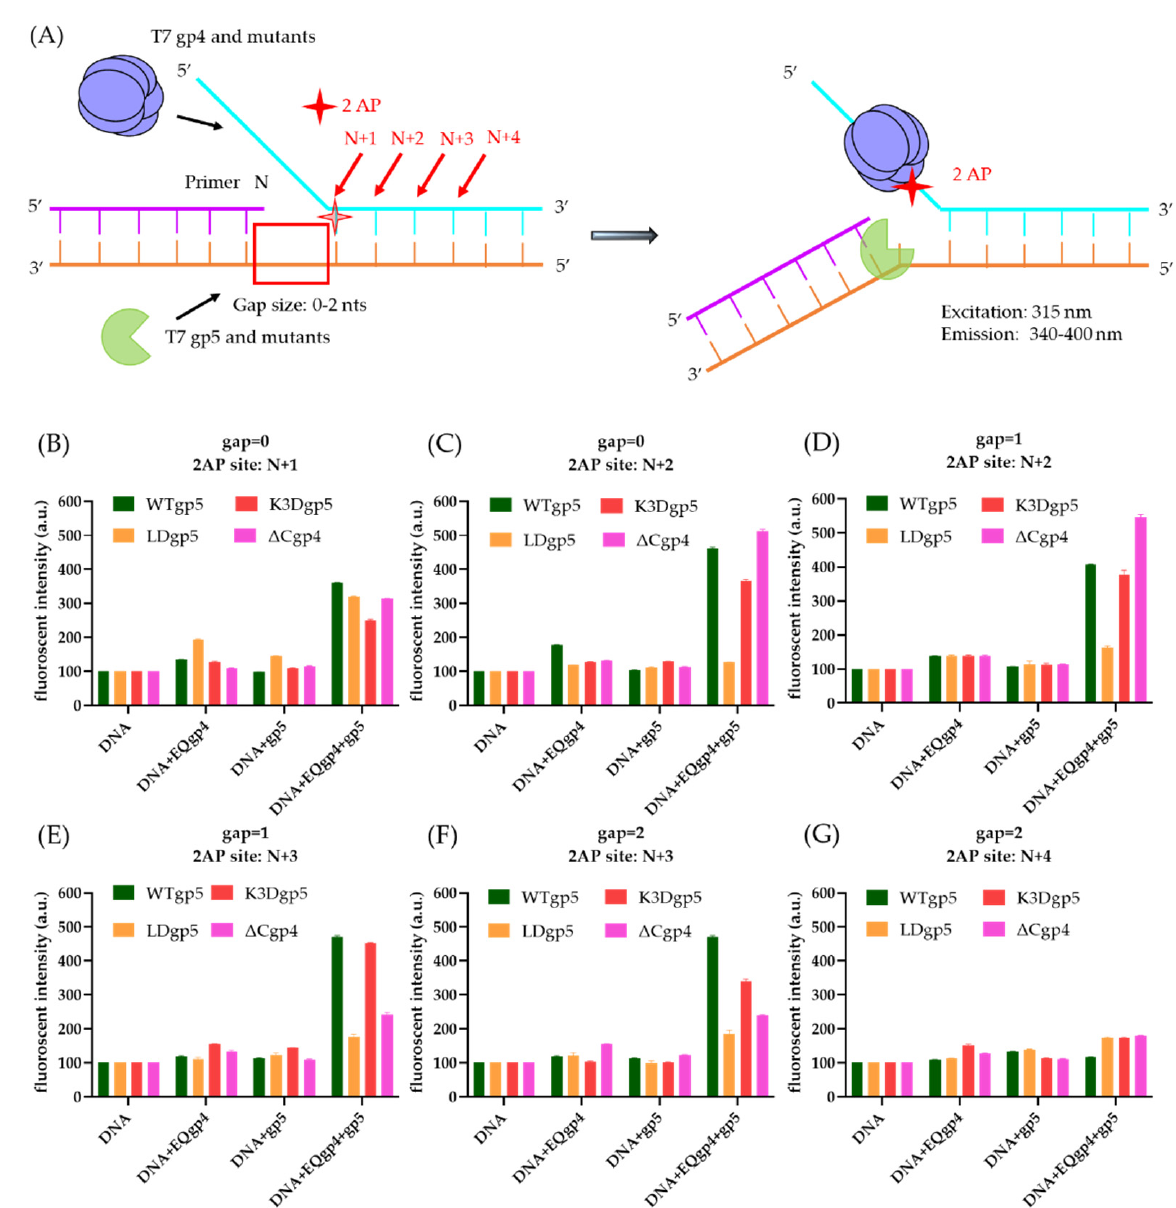
Figure 5. Cooperative separation of base pairs at the fork junction by gp4 and gp5-trx. ( A ) Design the replication fork with 2-AP labeled on the lagging strand. The primer-end (N) and subsequent base pairs on the duplex were N + 1 to N + 4. The 2-AP was shown as a red sticker on the duplex of the fork. ( B – G ) Integration of the fluorescent intensities of 2-AP modified substrates with or without gp5-trx and gp4. The gap size and the location of the 2-AP were indicated in each panel. Standard deviations were collected from the average of three replicates.